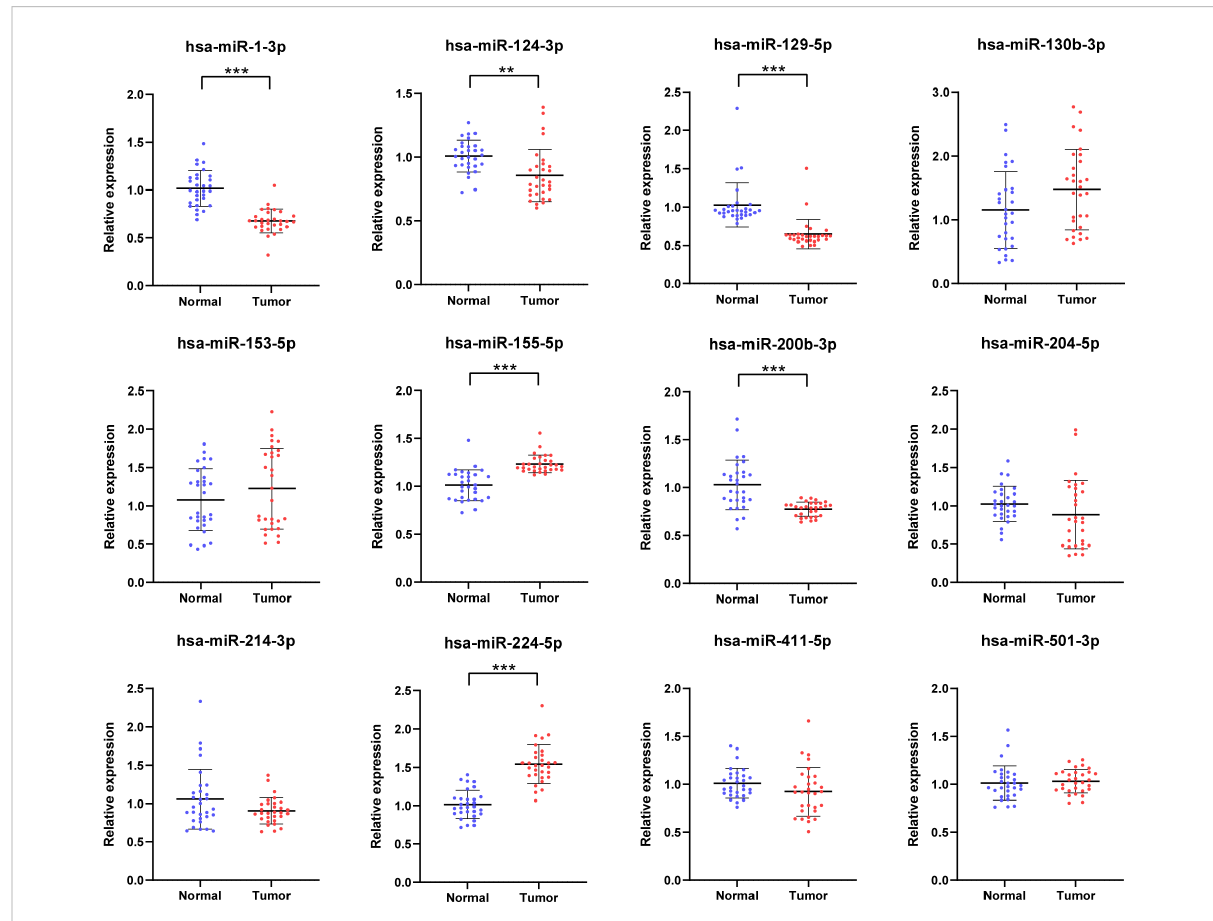
FIGURE 2 Relative serum expression levels of 12 candidate miRNAs. There were a total of 30 RCCs serum samples and 30 NC serum samples utilized in this phrase and 6 miRNAs ultimately showed signi fi cant difference. **p < 0.01, ***p <